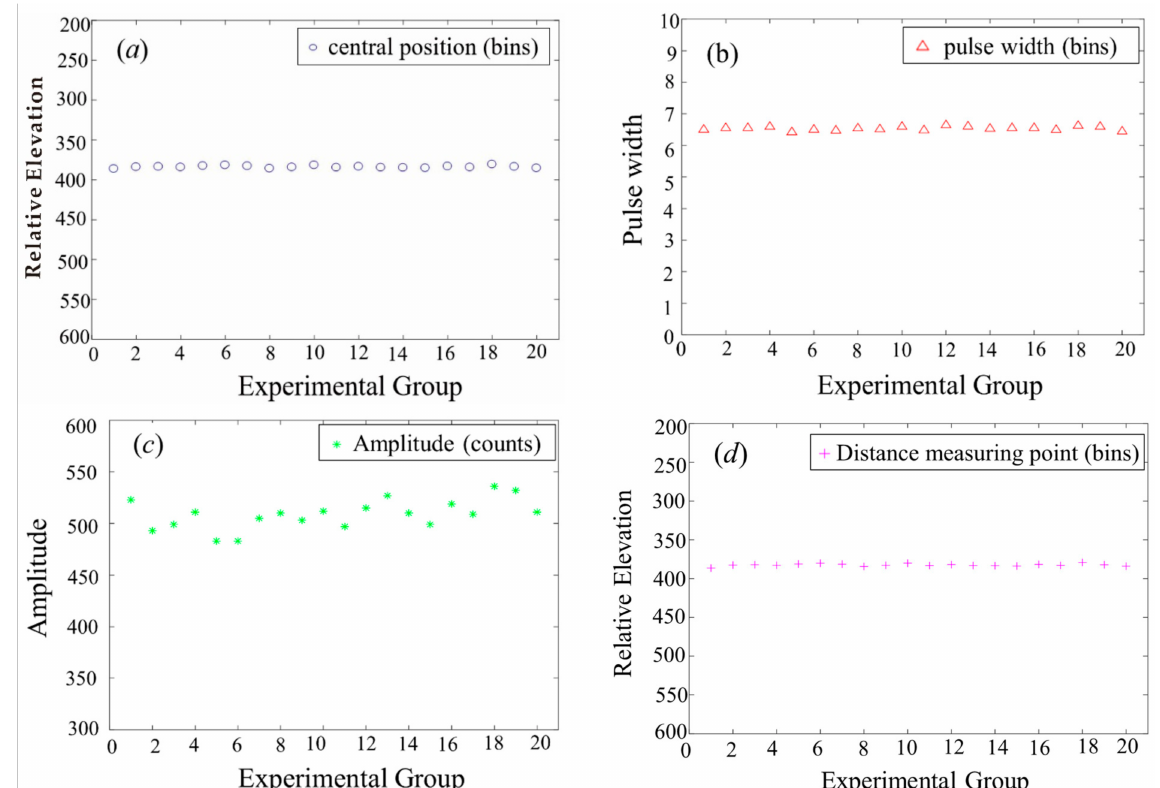
Figure 15. LiDAR echo decomposition results in Antarctica: ( a ) Central position; ( b ) Pulse width; ( c ) Amplitude; ( d ) Distance measuring